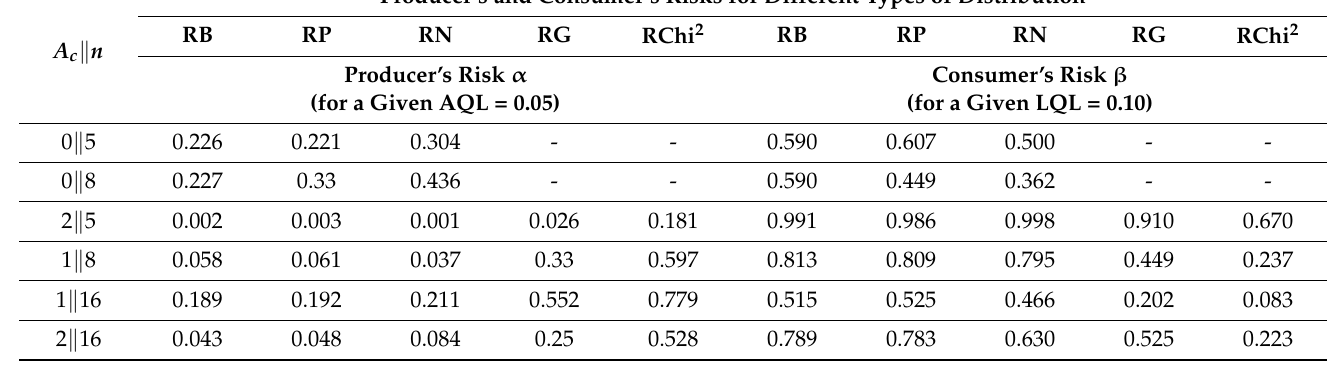
Table 3. Producer’s and consumer’s risks for different